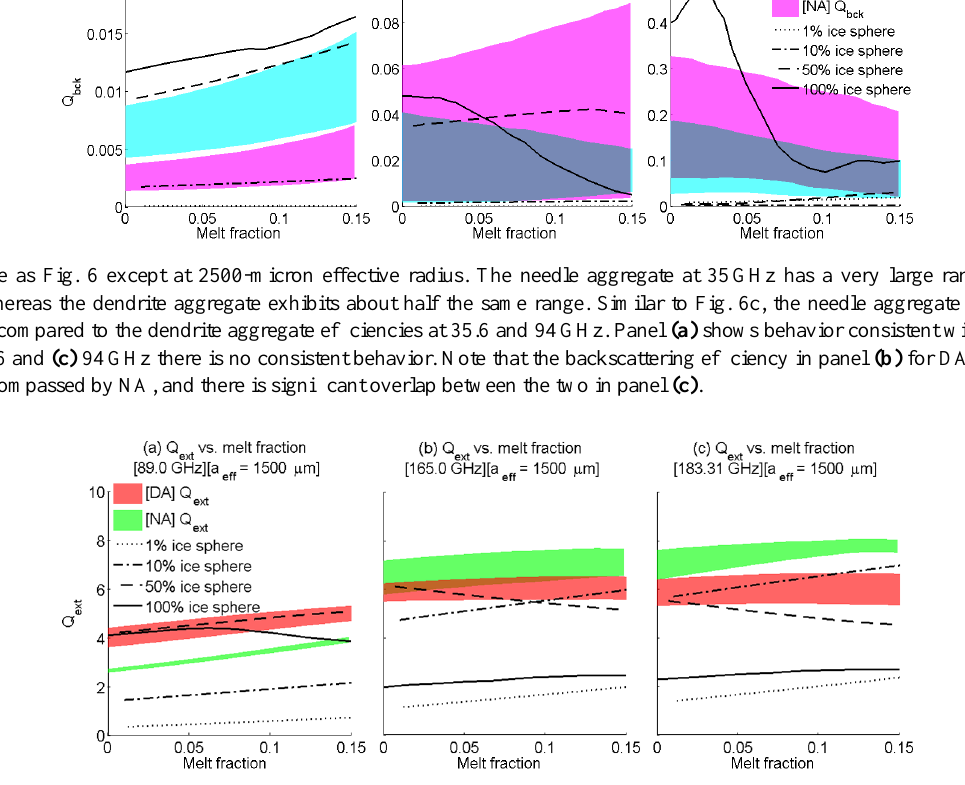
Figure 8. Extinction efficiencies ( Q ext ) computed for both aggregates and spheres at an effective radius of 1500 microns for (a) 89, (b) 165, and (c) 183.31GHz. Similar to previous plots, shaded regions represent the ranges of Q ext due various orientations of the particle relative to incident radiation. Vertical axes are on the same